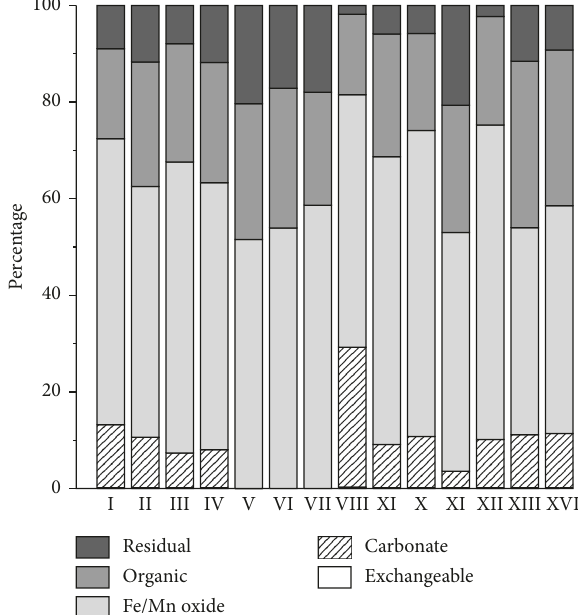
Figure 3: Distribution of lead in soils and sediments of the La Zacatecana Lagoon as determined by sequential